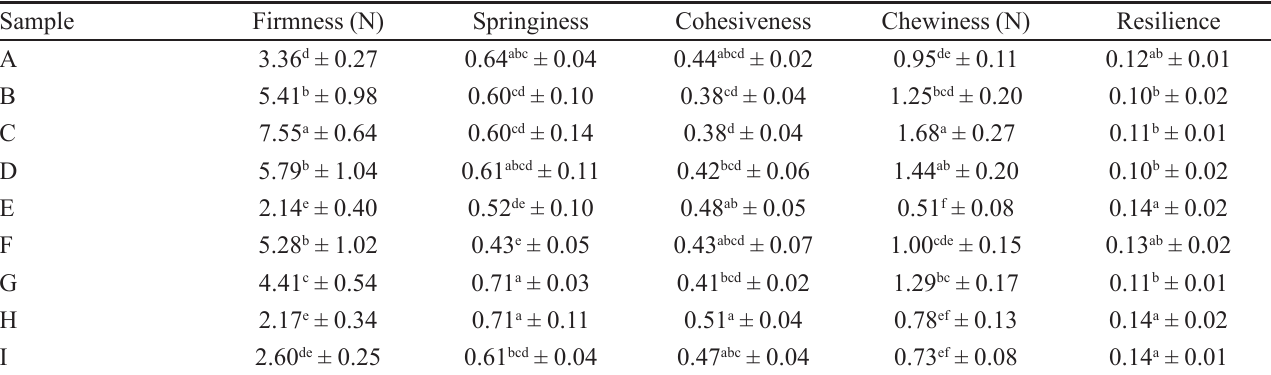
TABLE II - Crumb texture of panettone